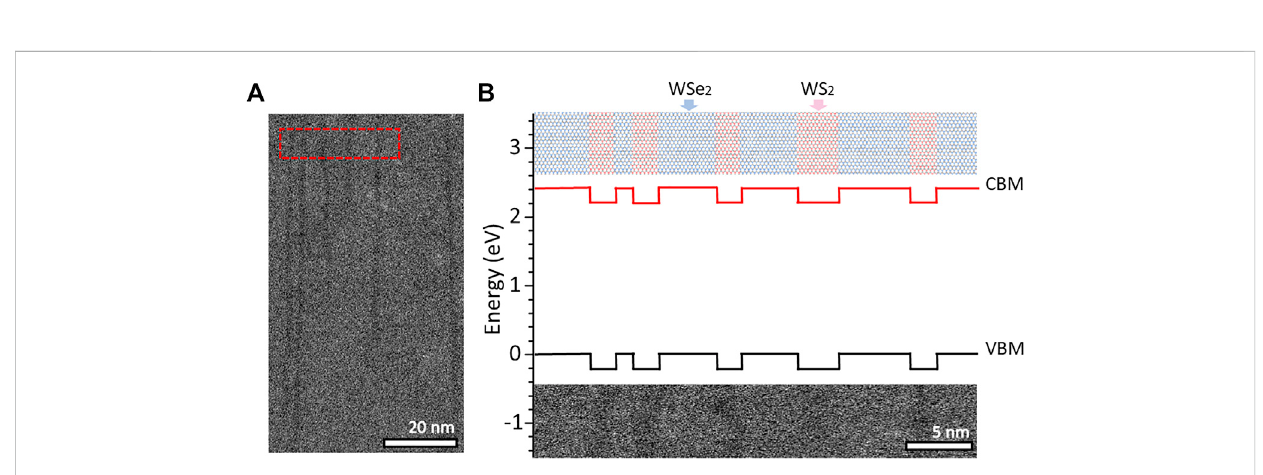
FIGURE 5 WS 2 quantum superlattice. (A,B) Atomic structure model of the WSe 2 /WS 2 superlattice and the calculated band structure. The red and black solid lines represent the valence band maximum (VBM) and the conduction band minimum (CBM), respectively.